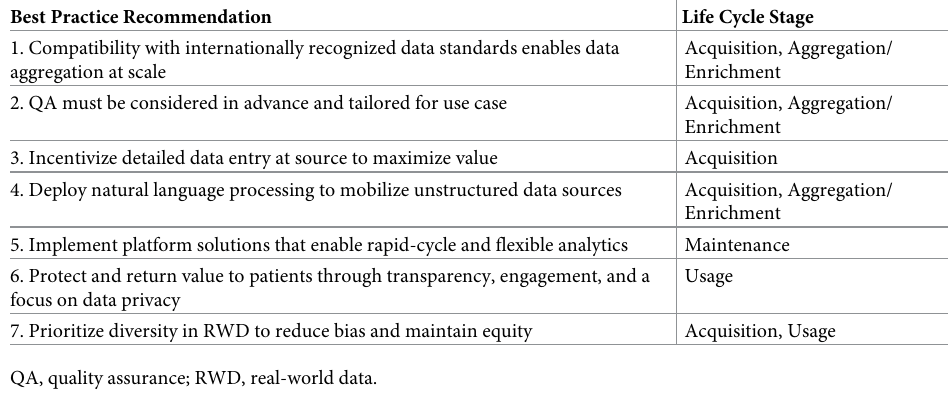
Table 1. The best practices identified in this table are areas where there is heterogeneity in best practice or where there are opportunities for innovation in the next 5 to 10 years. They have been linked to the RWD life cycle stages identified in Fig